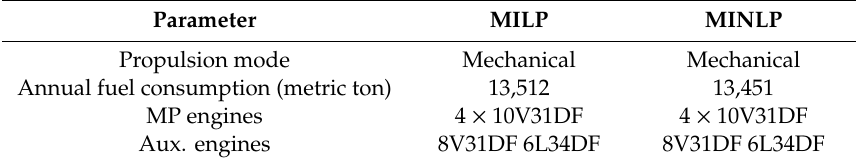
Table 6. Cruise ship: optimization